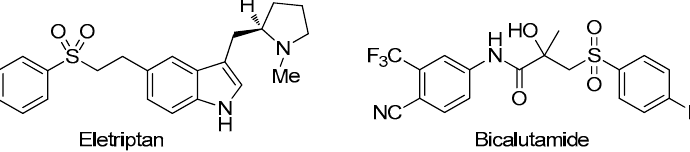
Figure 1. Examples of pharmaceutical molecules with structural unit of alkyl aryl sulfone. Molecules 2017 , 22 , 39;